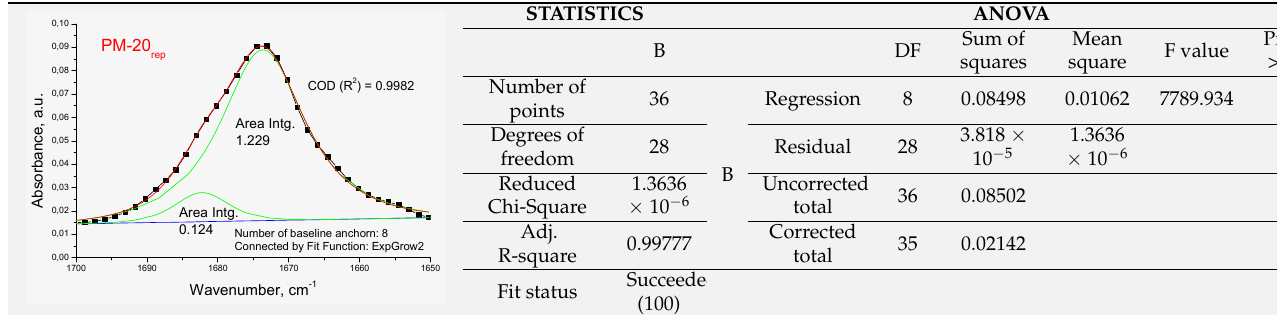
Table A10. Sample P-25